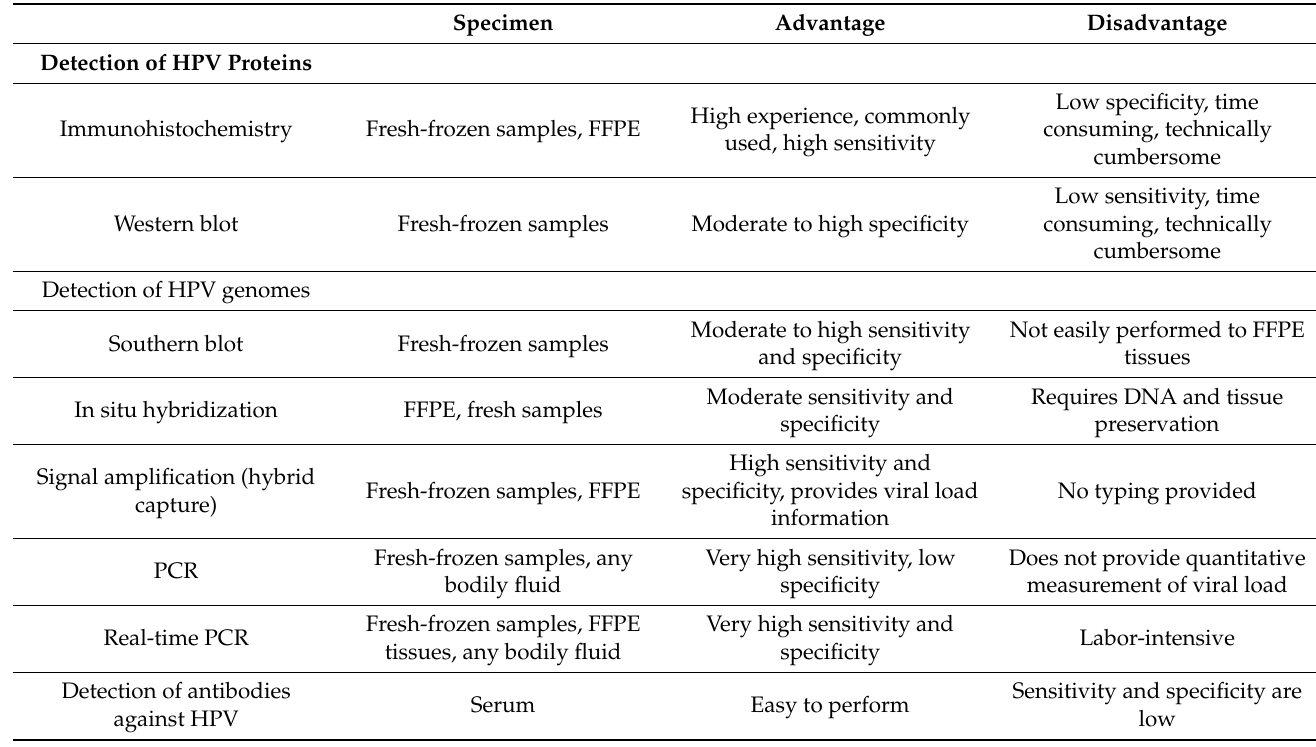
Table 2. Human papillomavirus detection methods